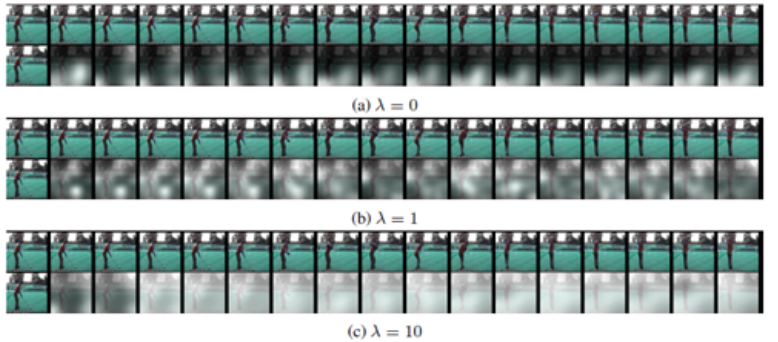
Figure 9. Attention penalty value changes in visual attention according to the λ value. The white regions are where the model is looking and the brightness indicates the strength of focus. Setting λ = 0 corresponds to the model that tends to select a few locations and stay fixed on them. Setting λ = 10 forces the model to gaze everywhere, which resembles average pooling over